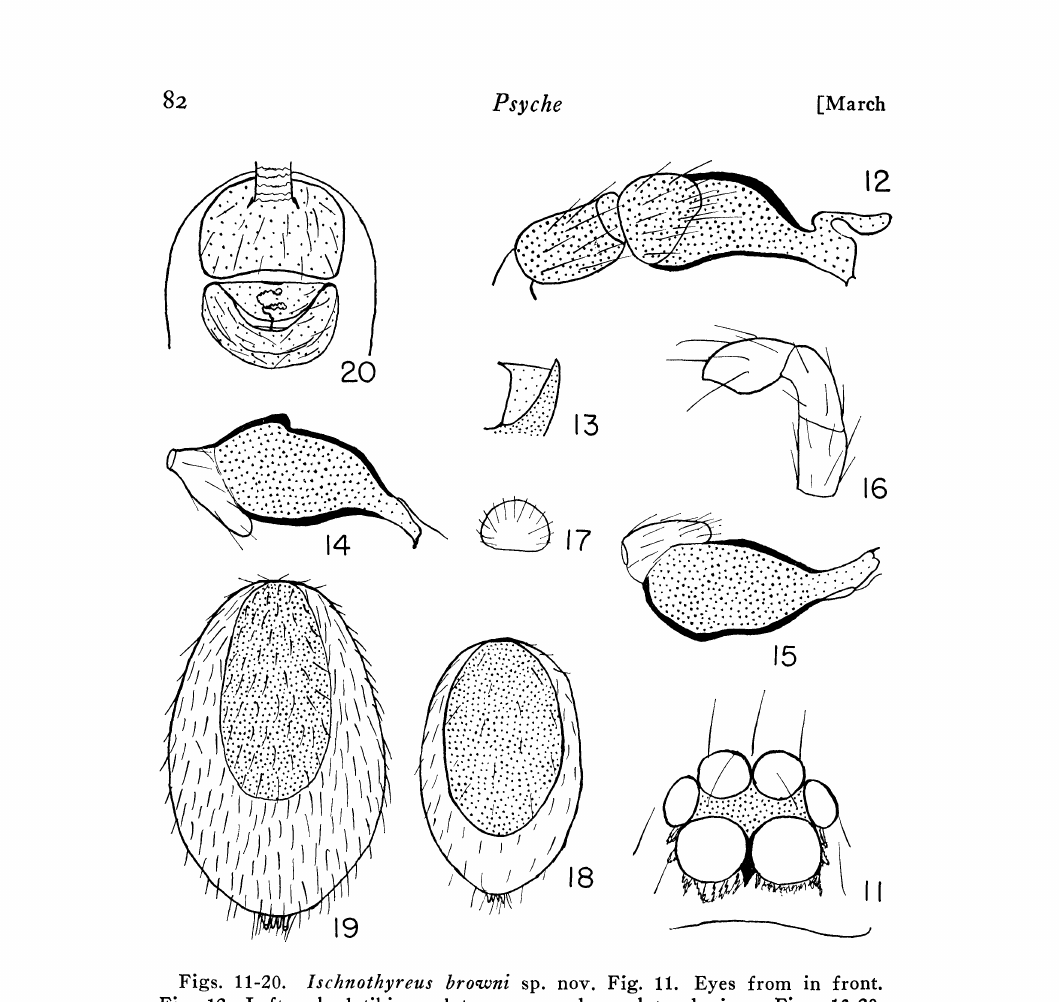
Figs. 11-20. Ischnothyreus broni sp. nov. Fig. 11. Eyes from in front. Fig. 12. Left palpal tibia and tarsus; nearly prolateral view. Figs. 13-20. Ischnothyreus indressus sp. nov. Fig. 13. Distal end of right maxilla. Figs. 14-15. Nearly retrolateral and prolateral views of left palpal tarsus, respectively. Fig. 16. Right palpal femur, patella and tibia; nearly pro- lateral view. Fig. 17. Genital aperture of male. Fig. 18. Abdomen of male; dorsal view. Fig. 19. Abdomen of female; dorsal view. Fig. 20. Ventral and epigastric scuta of female with epigynal area. oo were taken in one day at Gatun, Canal Zone and all came